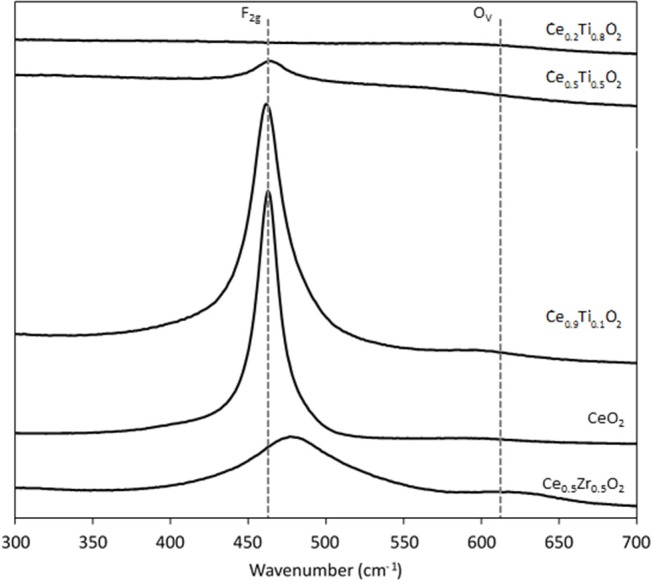
Raman spectra of the synthesized Ce0.5Zr0.5O2 and the CexTi1−xO2 supports, showing the F2g mode and the Ov modes.